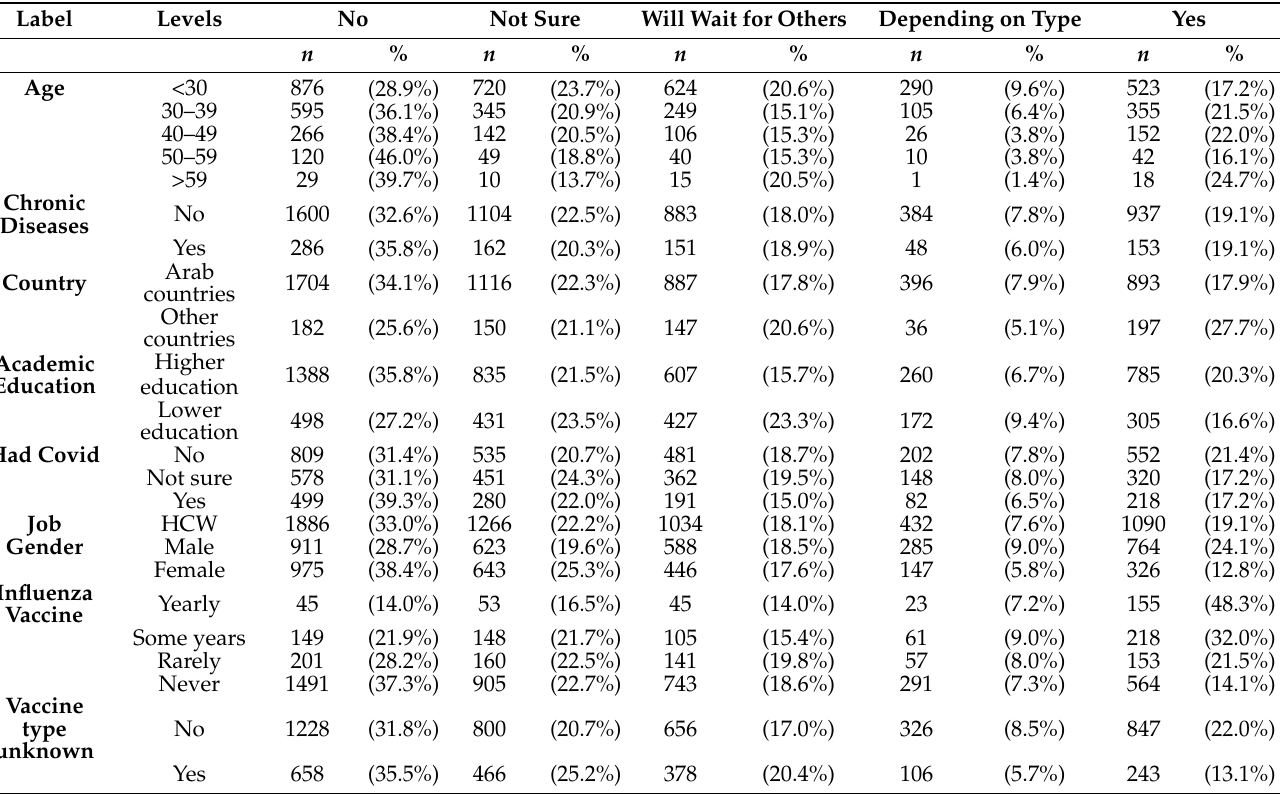
Table 2. Characteristics of HCWs with Distribution of COVID-19 Vaccine Willingness.